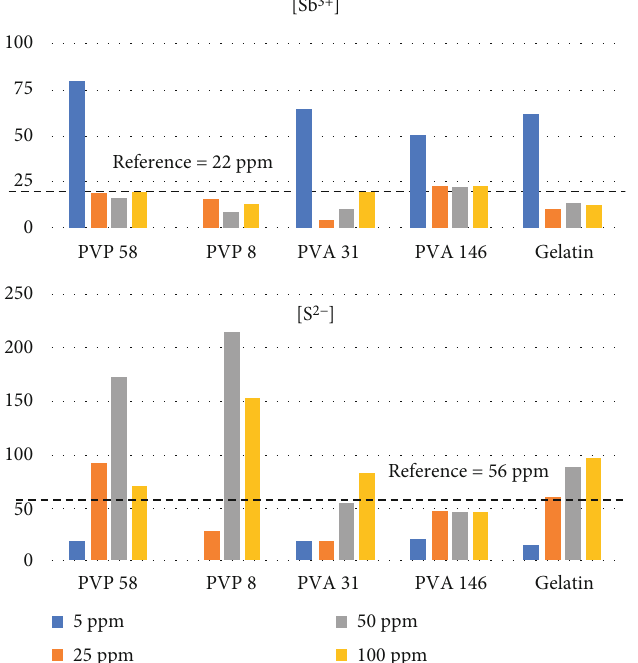
Figure 7: The concentration of Sb 3+ and S 2- in the presence of the antiscalants at all dosages. The dashed line represents the concentration of the ion of interest for reference (without antiscalants).